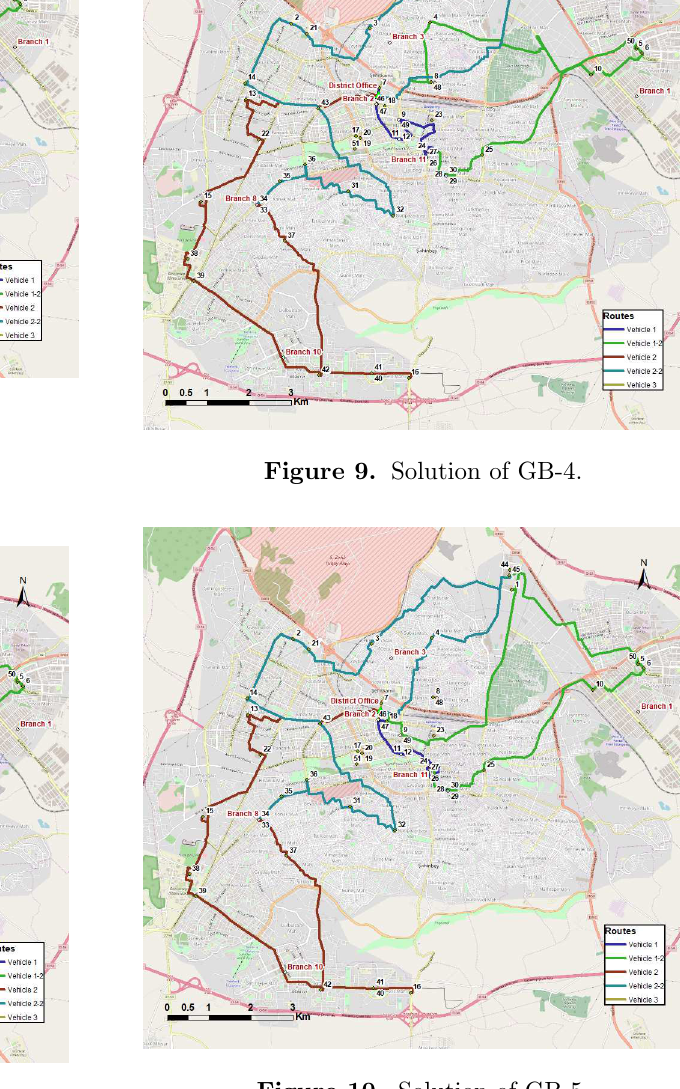
Figure 7. Solution of GB-2.